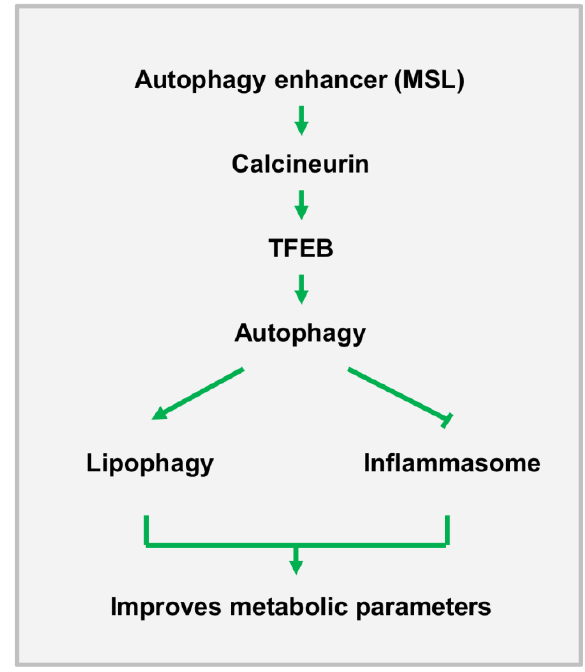
FIGURE 1: A diagram of the effect of autophagy enhancer on in vivo metabolism. MSL enhances autophagic activity through cal- cineurin activation, which leads to improved metabolic profile of obese mice by increasing lipophagy and suppressing inflam- masome activation or metabolic